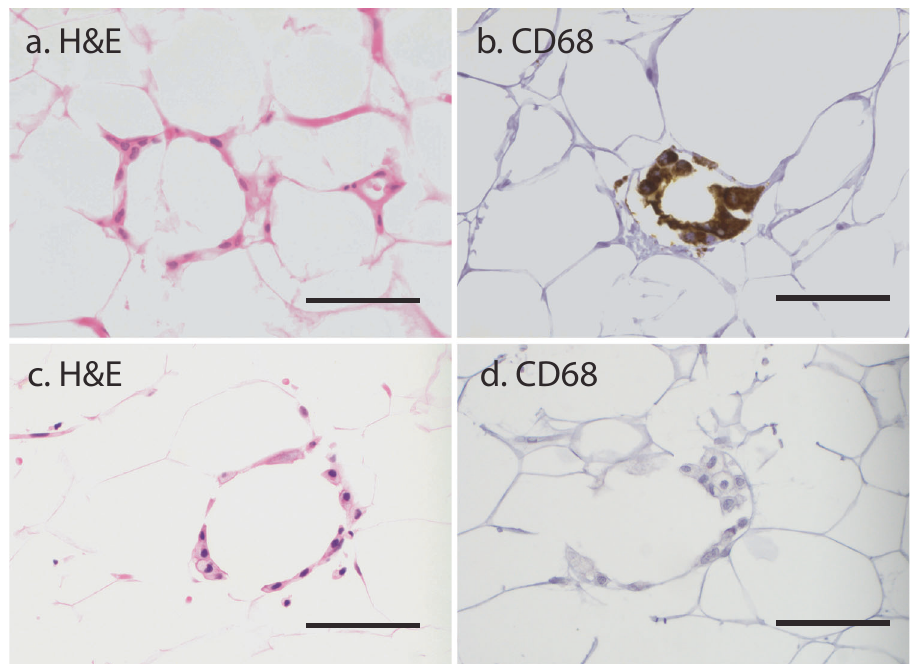
Fig. 2 Photomicrographs of crown-like structures of the breast in representative cases. H&E CLS-B: a continuous ring of macrophages surrounding a white-fat adipocyte can be seen in H&E sections ( a , c ). CD68 + CLS-B: immunohistochemistry for CD68 highlights the cytoplasm of macrophages ( b ). In some cases, histologic CLS-B (hCLS-B) were CD68 negative ( d ). Colour balancing has been applied to all pixels uniformly in each individual panel. The scale bars correspond to 70